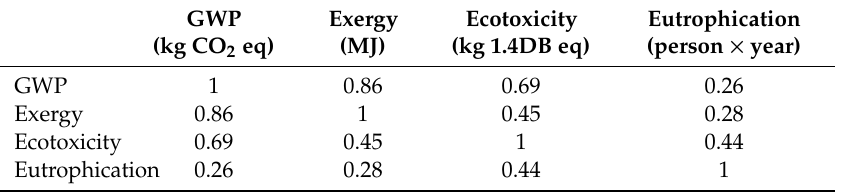
Table A3. Correlation of the four environmental indicators by daily totals (sum of B, L, D) and by